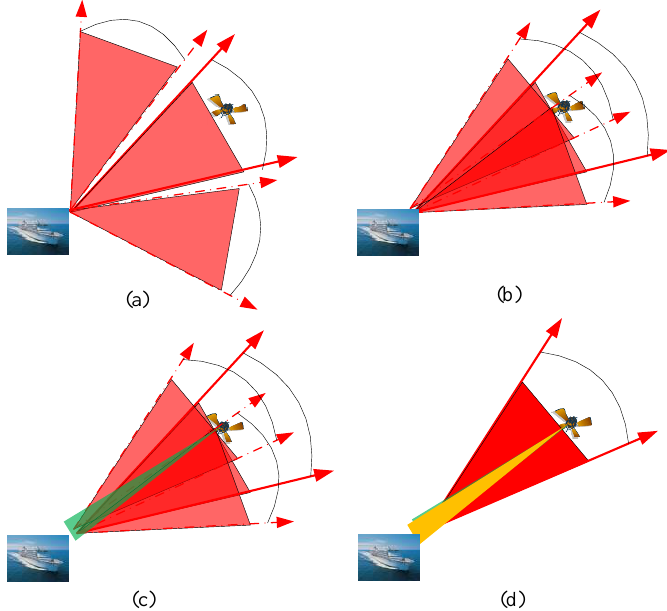
Figure 1. Schematic of acquisition and tracking. ( a ) The shipborne acquisition, tracking, and pointing (ATP) system initiates the acquisition process. The shipborne ATP and satellite activate their beacon lasers and point at each other using the predicted ephemeris. ( b ) The satellite detects the uplink beacon laser and initiates precise tracking. ( c ) The shipborne ATP detects the downlink beacon laser and initiates precise tracking. ( d ) Bidirectional tracking and locking between the satellite and shipborne ATP is established until the laser communication is terminated.